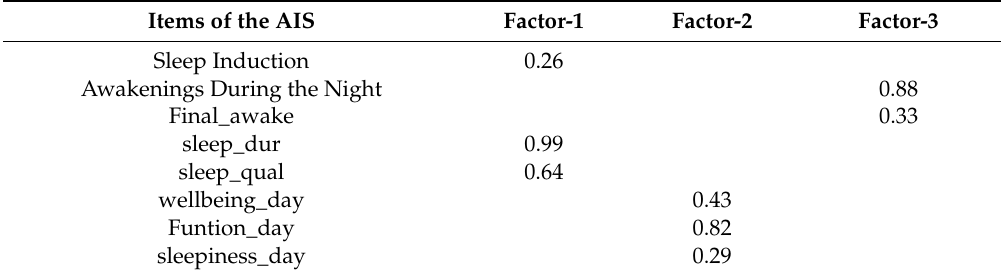
Table 4. Pattern matrix of the Athens Insomnia Scale (AIS) scores in Indian computer professionals. Items of the AIS